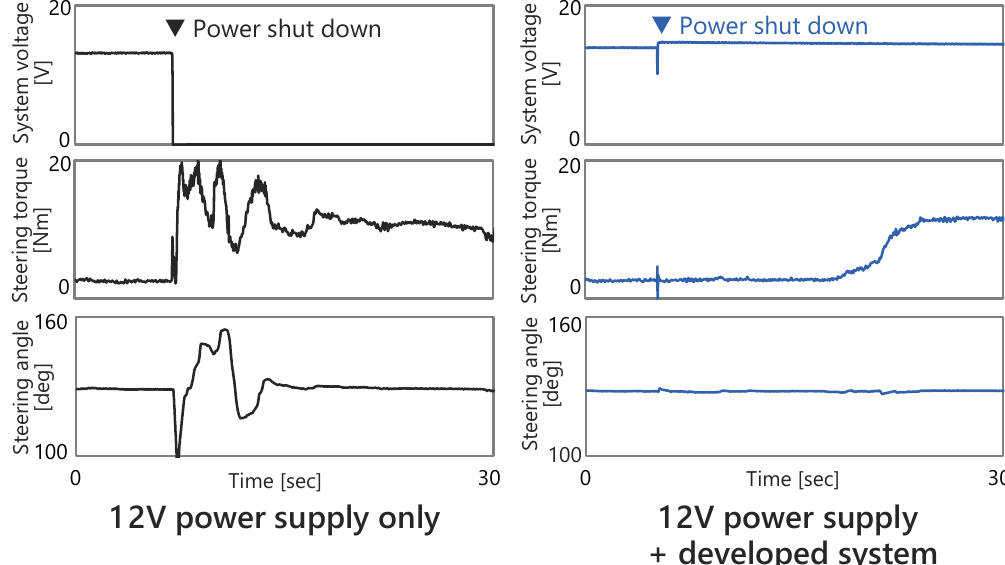
Figure 9. Comparison of steering force change when the 12 V power supply is shut down.